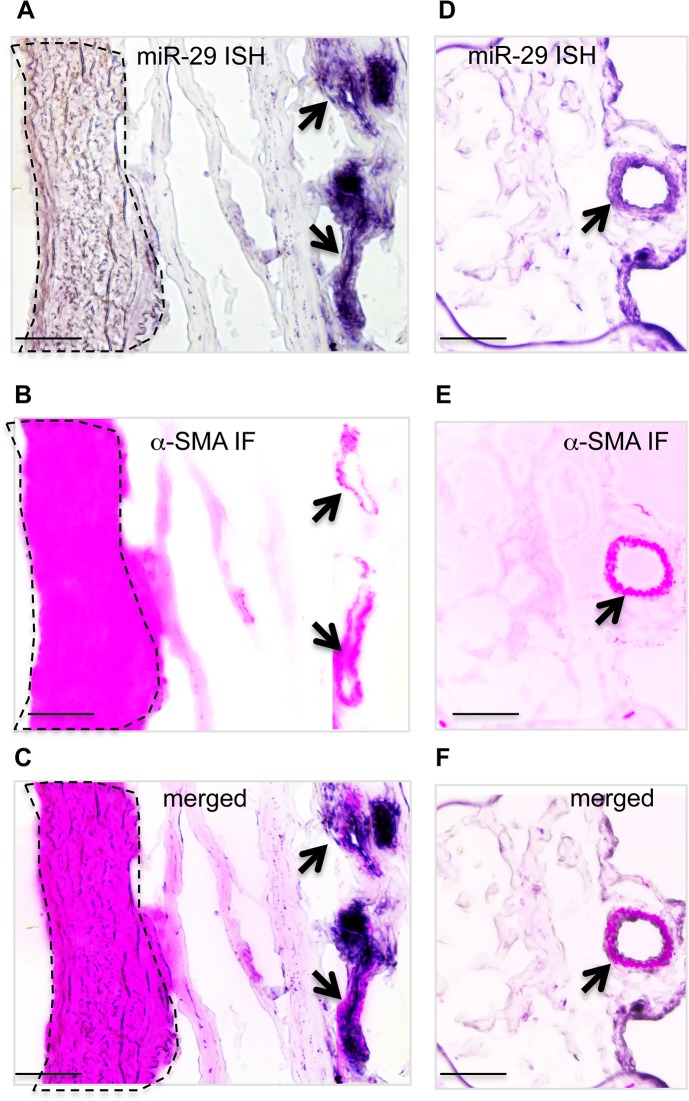
Expression of miR-29 in human lung vasculature.
(A, B&C) High miR-29c ISH signal (purple) co-localizes with α-SMA IF staining signal (red) of small vessels (black arrow), while the level of miR-29c in vSMCs (media layer) of nearby large pulmonary arteries (highlighted area by dashed lines) is much lower. (D, E&F) miR-29 is also highly expressed in vSMCs of distal pulmonary artery, where it co-localizes with α-SMA IF staining signal (black arrow). Scale bar: 50μM.